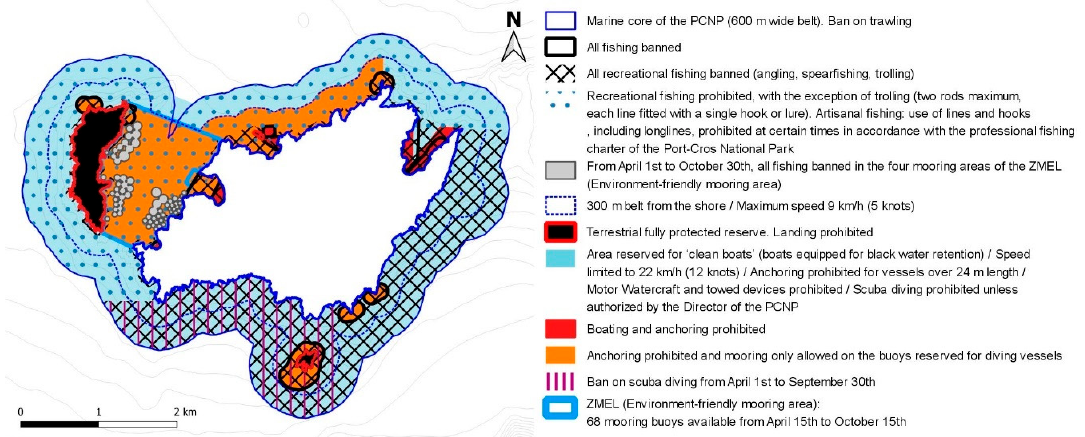
Figure 2. Boating, anchoring, scuba-diving, artisanal and recreational fishing regulations within different areas of the Port-Cros Archipelago (PCA) MPA (Port-Cros National Park). Other regulations are not shown on this map. Original drawing © Marie Clap (PCNP).